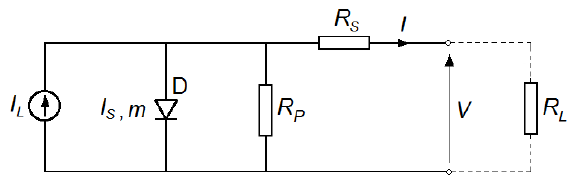
Figure 1. One-diode equivalent circuit of a solar cell.